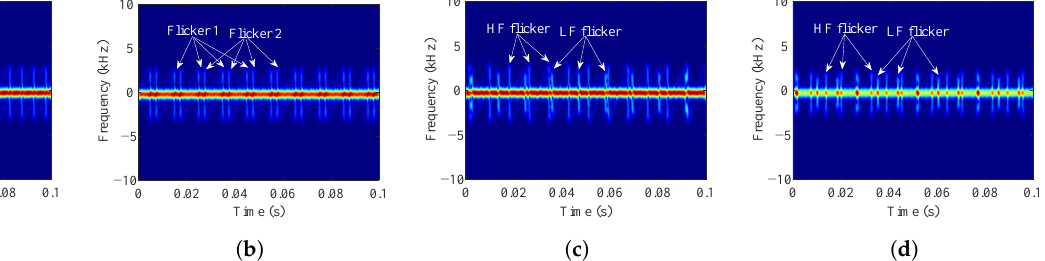
Figure 5. Drone time–frequency spectrum electromagnetic simulation in different states. ( a ) Type 2. ( b ) Type 4. ( c ) Type 6. ( d ) Type